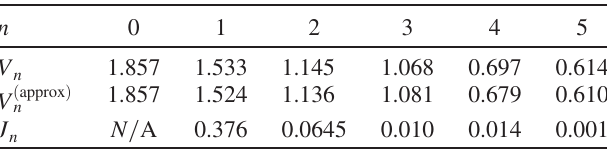
TABLE I. Direct interaction V for the Wannier orbitals in units of e 2 = ð ϵ L V 0 ; V 1 … is presented in Fig. 6(a). Here, V interaction term estimated by the point-charge approximation (see the